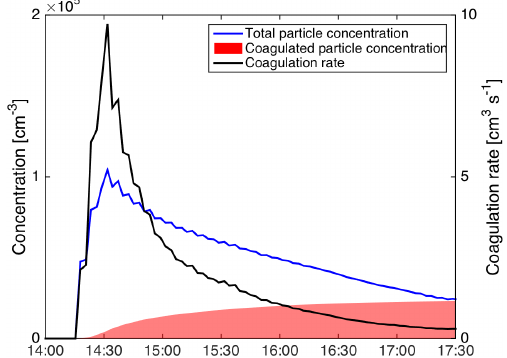
Figure 7. The SOA particles form aggregates at the early stage of their growth. After the coagulation rate has slowed, the aggregates grow by vapour condenzation to form non-spherical particles. The number of the single SOA particles in the aggregate is illustrative and does not necessary describe the real aggregates in the CLOUD